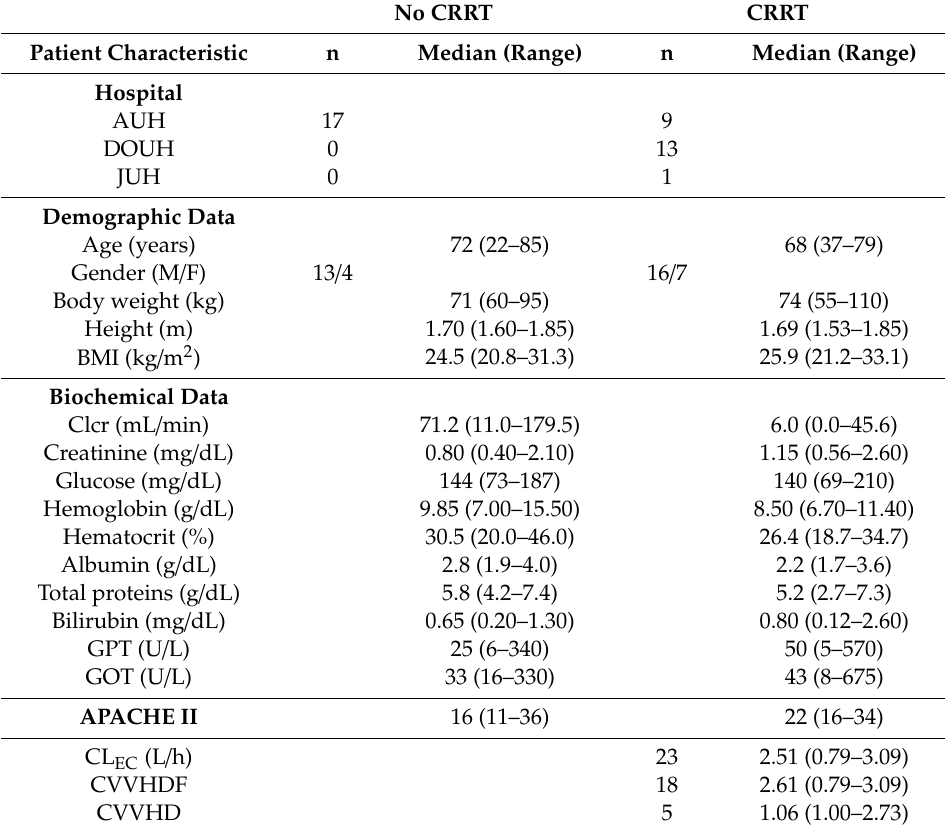
Table 1. Hospital, demographic and biochemical data, and APACHE II health score (Acute Physiology and Chronic Health Evaluation II) of the 40 patients. AUH: Araba University Hospital; DOUH: Doce de Octubre University Hospital; JUH: Joan XXIII University Hospital; CRRT: continuous renal replacement therapies; BMI: body mass index; Clcr: creatinine clearance; GOT: glutamate